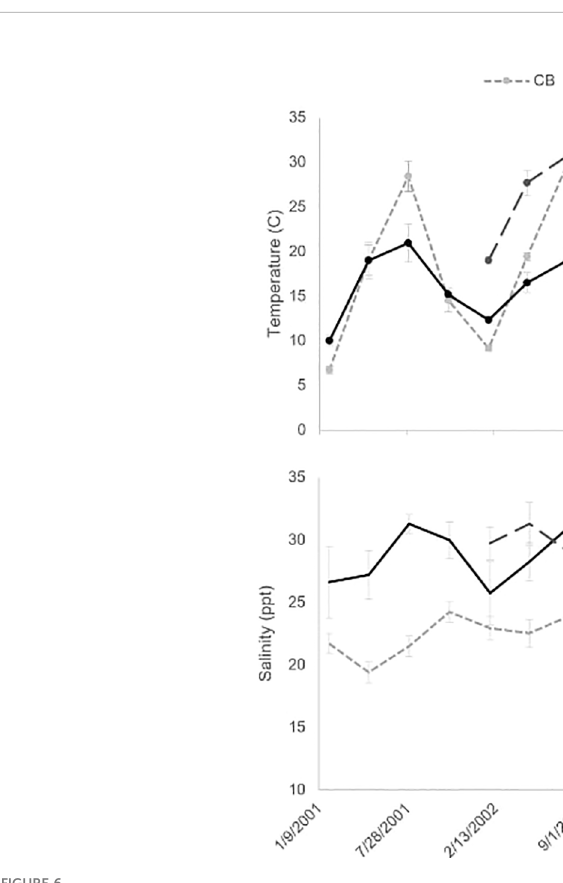
FIGURE 6 Average temperature (°C; top) and salinity (ppt; bottom) as measured during quarterly deployments (± SD) during period 1 for Chesapeake Bay ((CB) light gray circle with dashed line), San Francisco Bay ((SF) dark circle with line), and Tampa Bay ((TB) medium gray circle with dashed line). Measurements were taken at 0-, 1-, and 2-M depths at each site and then averaged across sites and depths for each